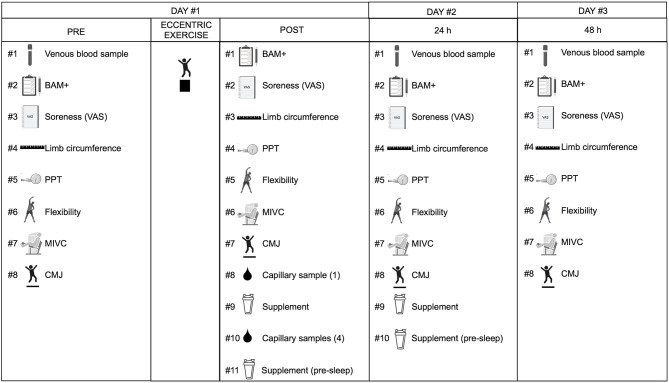
Overview of the experimental protocol. Twenty young adults (10 men; 10 women) performed an acute bout of eccentric exercise and were studied over 48 h of post-exercise recovery. During the recovery period, participants received a ketone monoester (KET) or energy-matched carbohydrate (CON) supplement two times per day (in the morning immediately after testing and in the evening 30 min prior to sleep). Testing occurred at baseline (PRE) before the bout of eccentric exercise, and then immediately (POST), 24 h (24 h), and 48 h (48 h) after exercise and included the following: venous blood sample (except at POST), BAM+, VAS muscle soreness, limb (thigh and calf) circumference, PPT, flexibility, MIVC, and CMJ. Capillary blood samples were taken before (0 min) and after (30, 60, 120, 180 min) intake of the first supplement serving. BAM+, brief assessment of mood adapted; CMJ, counter-movement jump; CON, carbohydrate control group; KET, ketone monoester group; MIVC, maximal isometric voluntary contraction; PPT, pressure-pain threshold; VAS, visual analog scale. Figure created with BioRender.com.